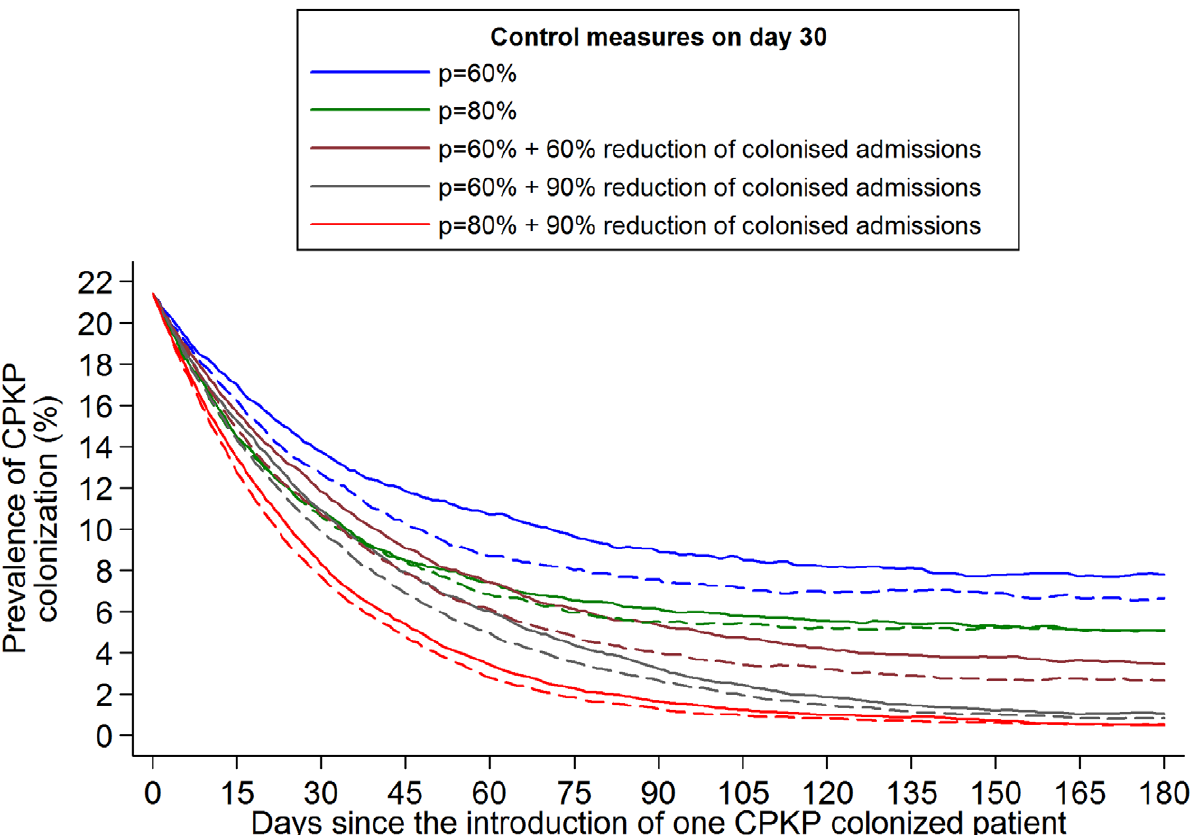
Figure 6. Impact of infection control measures on the prevalence of CPKP colonization in an hyperendemic setting. Infection control measures start on day 0 where a high colonization prevalence of 21% was assumed. The evaluated scenarios include: 1 . Hand hygiene compliance p =60%, 2. p= 80%, 3. p =60% and reduce colonization prevalence on admission of CPKP by 60% (through active surveillance and subsequent isolation or strict contact precautions for positive patients), 4. p =60% and reduce colonization prevalence on admission of CPKP by 90%, 5. p =80% and reduce colonization prevalence on admission of CPKP by 90%. Dashed lines ( - - - ) correspond to the above scenarios with the addition of 50% reduction in the duration of antibiotic usage during patients’ stay in the unit (assuming a relative risk associated with antibiotic use equal to 3).